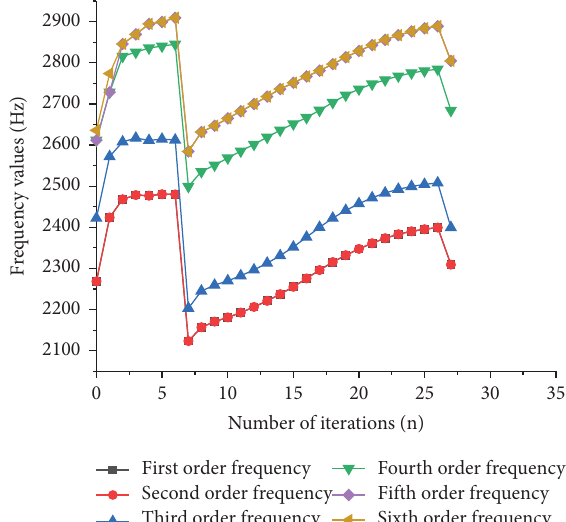
Figure 9: Schematic of the frst six-order frequency iteration process of gear dynamic topology